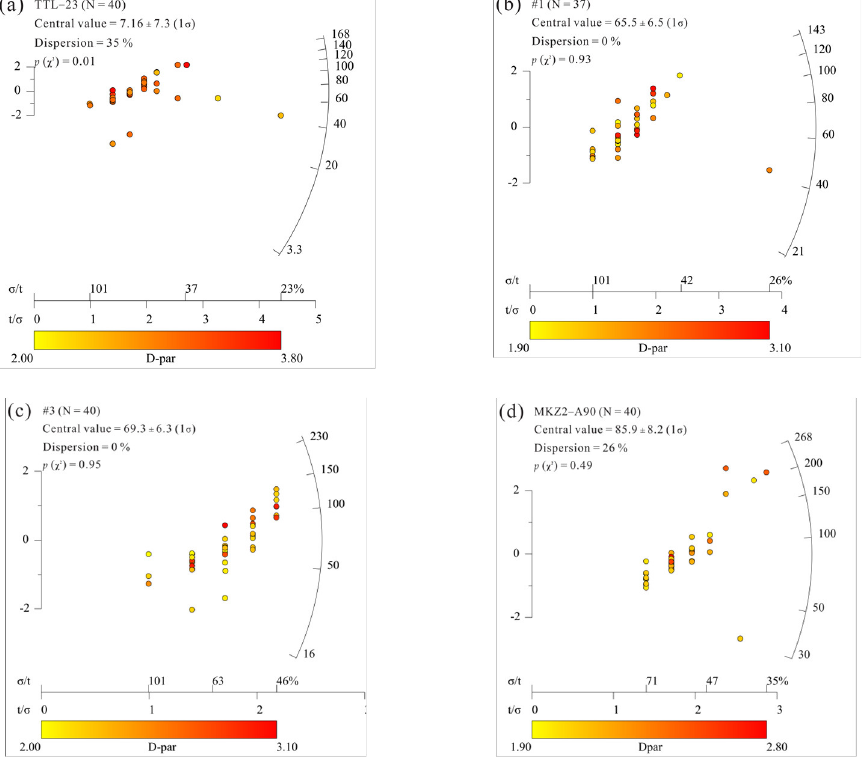
Figure 3. Radial plots of the single-grain AFT ages made using RadialPlotter [35]. ( a ) sample TTL-23 is country rock. ( b ) sample #1, ( c ) sample #3 and ( d ) sample MKZ2-90 are fault rock.